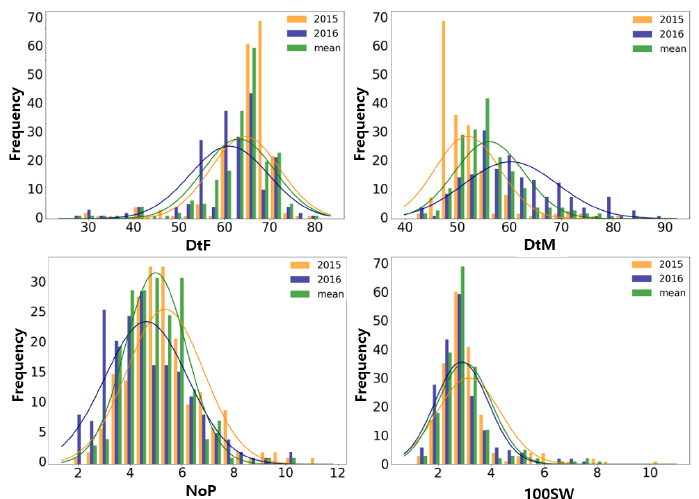
Figure 1. Distribution of agronomic traits (flowering, maturity, number of pods, and seed weight) in 203 wild soybean accessions. DtF, days to flowering; DtM, days to maturity; NoP, number of pods; 100SW, 100-seed weight.